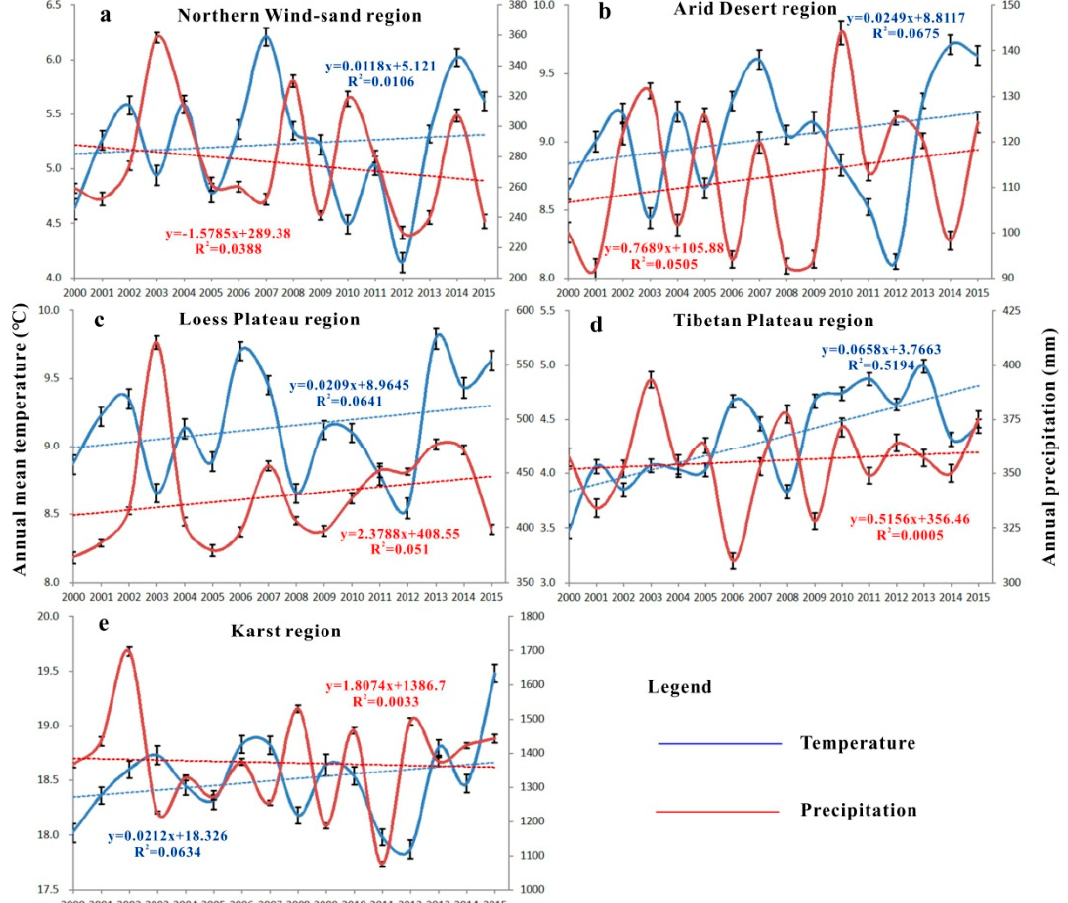
Figure 8. Interannual variations in the annual mean temperature and annual precipitation in the Northern Wind-sand region ( a ), Loess Plateau region ( b ), Arid Desert region ( c ), Tibetan Plateau region ( d ), and Karst region ( e ) from 2000 to 2015.